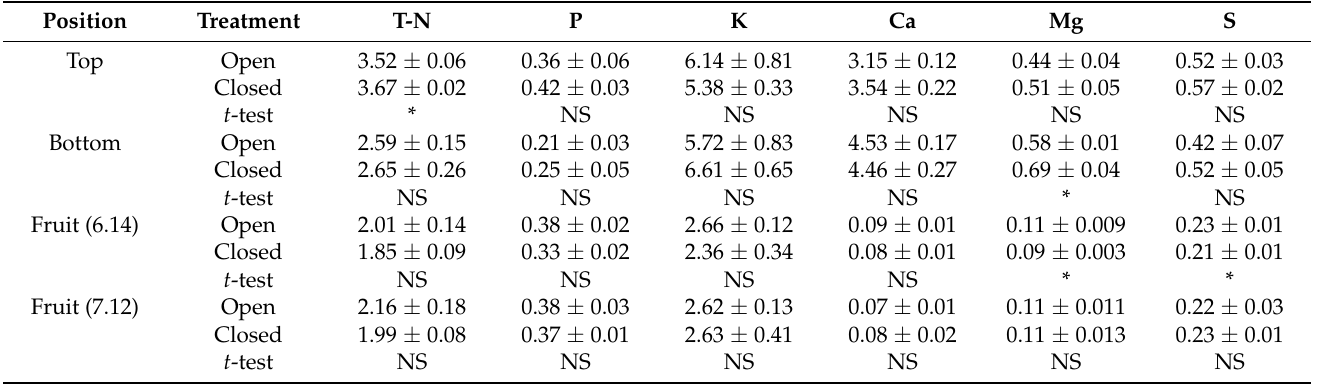
Figure 5. Comparisons of the productivity, sugar content, and percentage of blossom-end rot of sweet peppers between the closed-loop soilless culture under the nutrient balance control and the open-loop soilless culture in the experimental- ( a ) and commercial- ( b ) scale experiments ( t -test). NS: not significant. Table 1. Comparison of nutrient contents in leaves and fruits of sweet peppers between the open-and closed-loop soilless cultures under nutrient balance control in the commercial